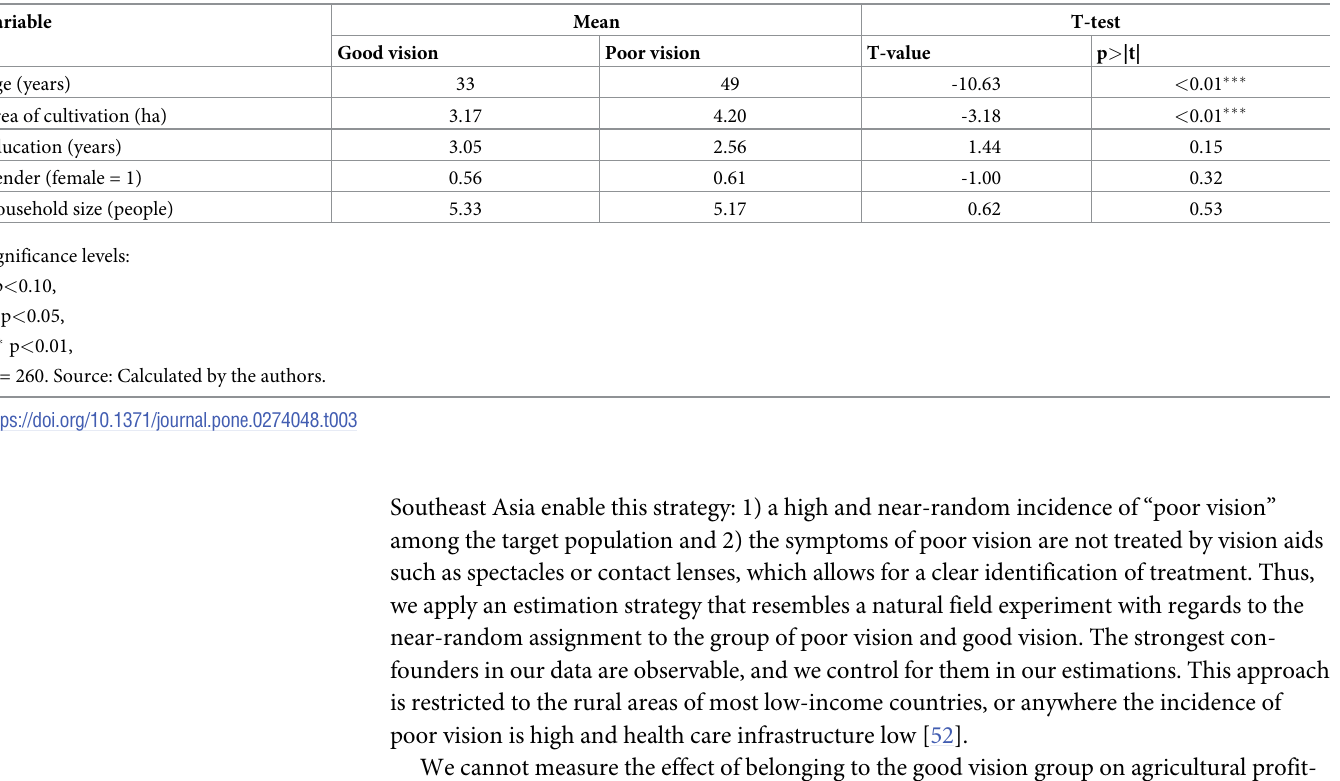
Table 3. Mean comparison of key variables for the good vision and poor vision